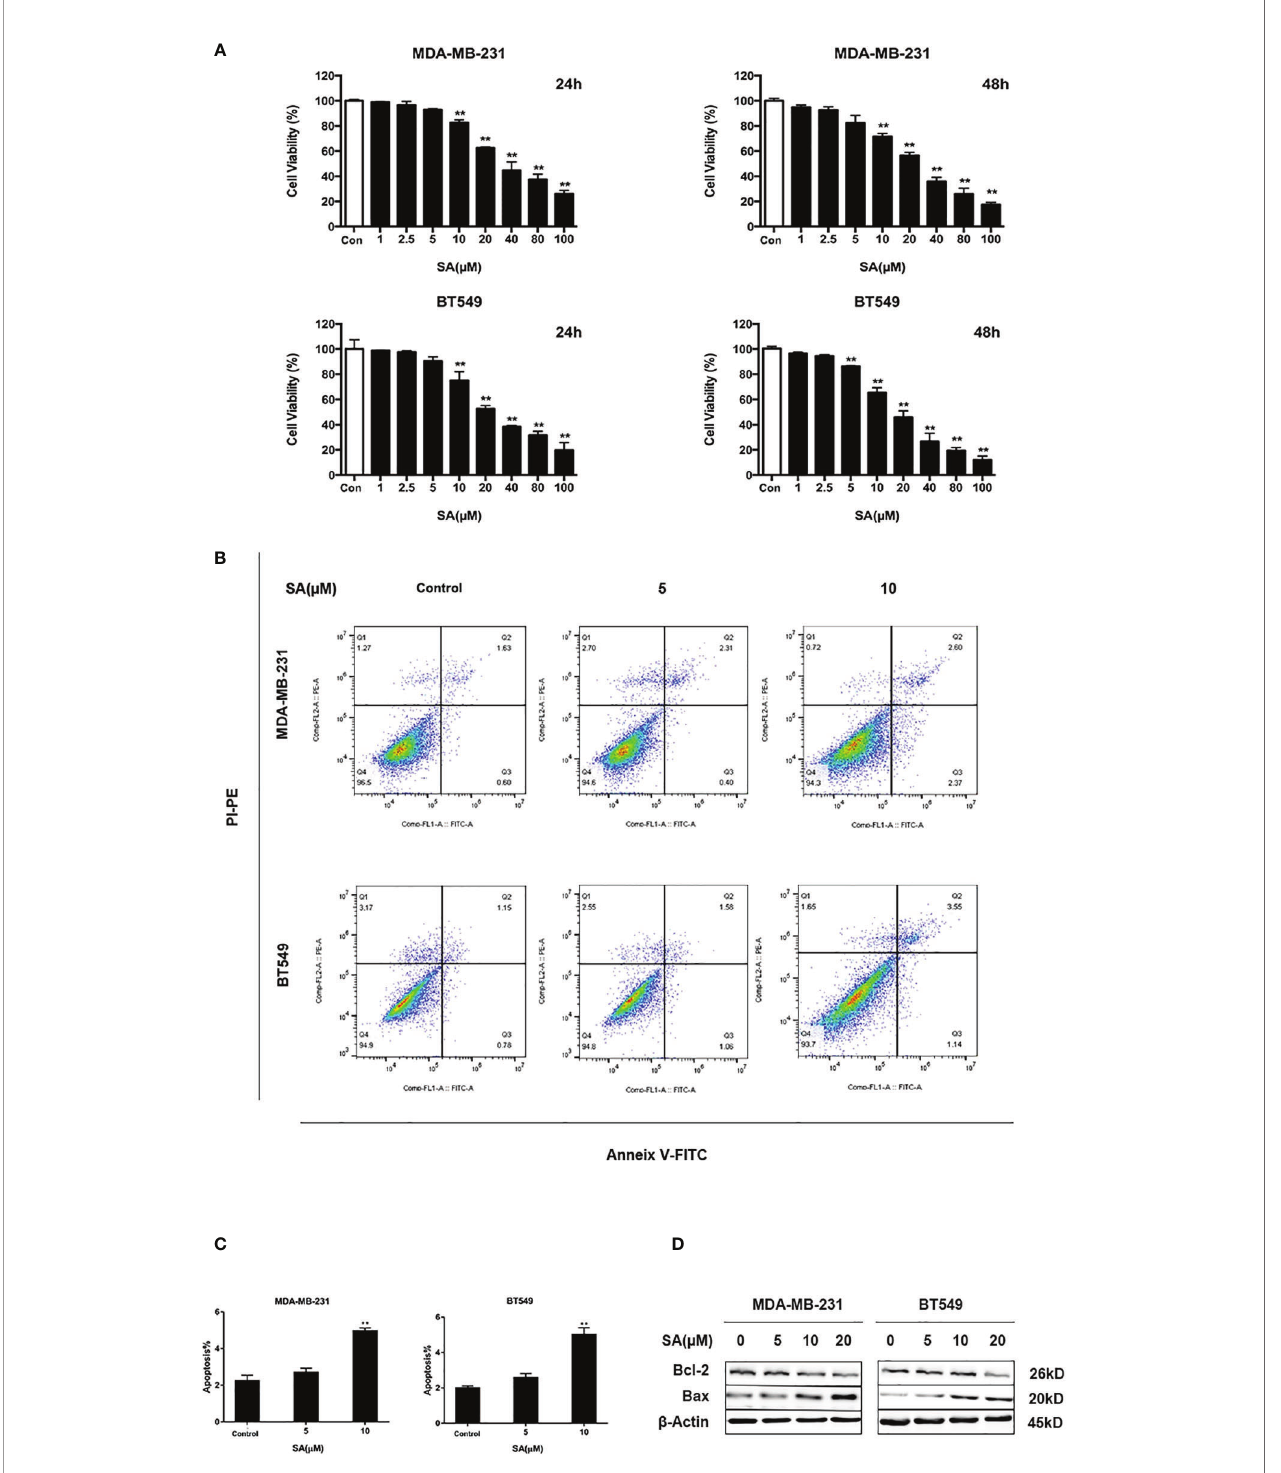
FIGURE 2 | SA inhibits TNBC cells proliferation. (A) Cell viability of MDA-MB-231 and BT549 cells after 24h and 48h SA treatment (Compared to the control group, ** p < 0.01). (B) Representative images of apoptosis in MDA-MB-231 and BT549 cells determined by Flow cytometry analysis after SA treatment. (C) Percentages of apoptotic cells in MDA-MB-231 and BT549 cells after SA treatment (Compared to the control group, ** p < 0.01). (D) Western blot analysis of Bax and Bcl-2 after SA treatment (Compared to the control group, ** p <